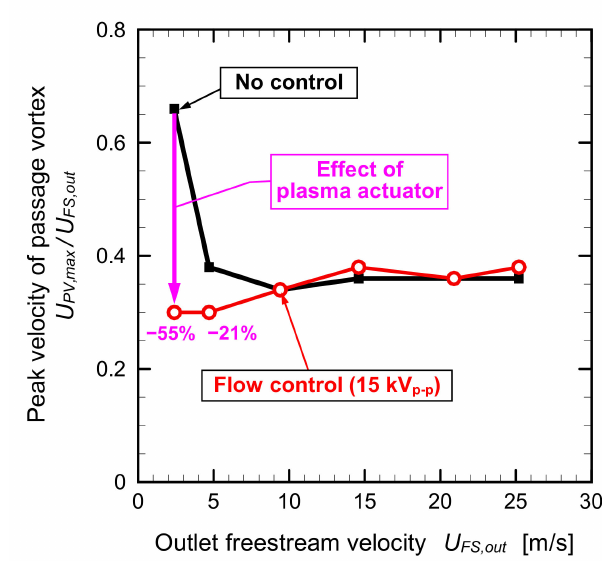
Figure 22. Peak velocity of passage vortex in center passage at various freestream